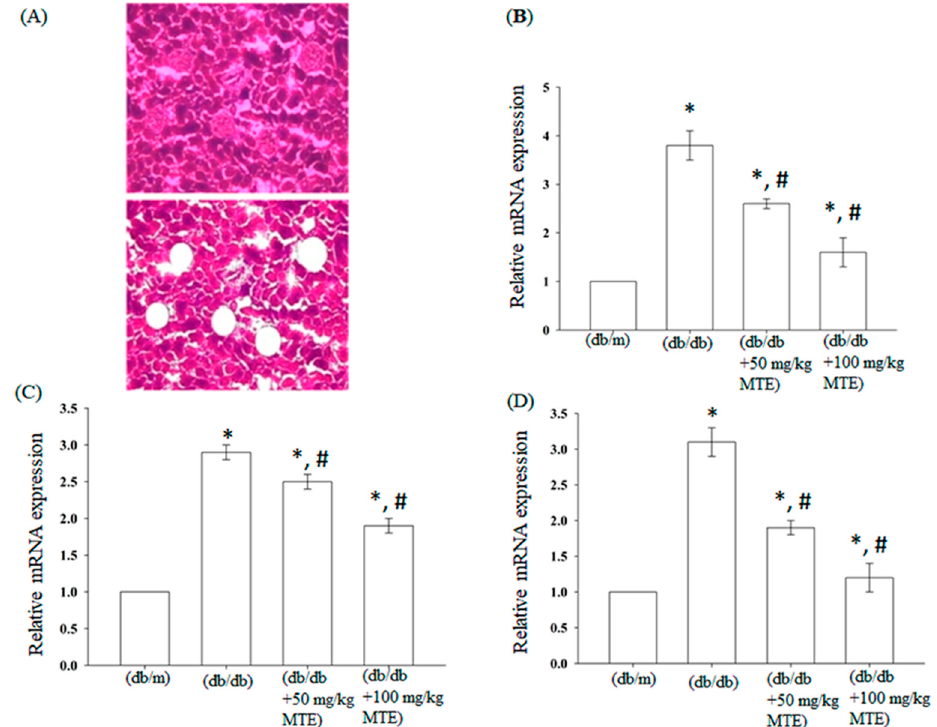
Figure 3. MTE reversed the diabetes-induced expression of fibrosis-related genes. ( A ) Renal tissue sections before (upper panel) and after (lower panel) laser capture microdissection. Quantitative RT-PCR analysis of ( B ) fibronectin, ( C ) TGF- β , and ( D ) collagen IV from the indicated treatment. The data represent the means and standard error obtained from at least three independent experiments *: p < 0.05 compared with db/m mice. #: p < 0.05 compared with db/db mice without